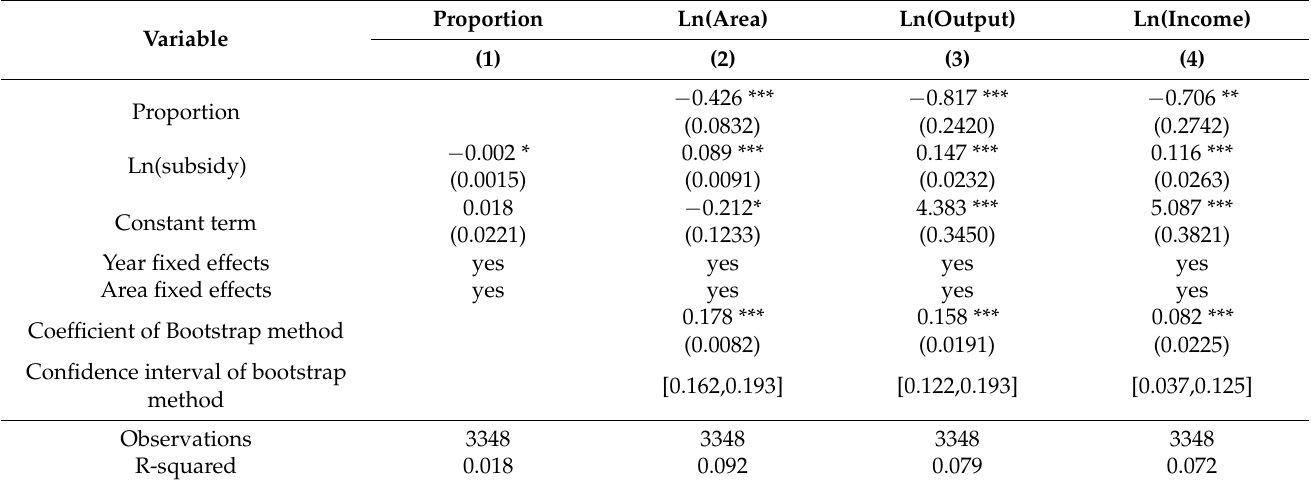
Table 8. Regression results of mediating